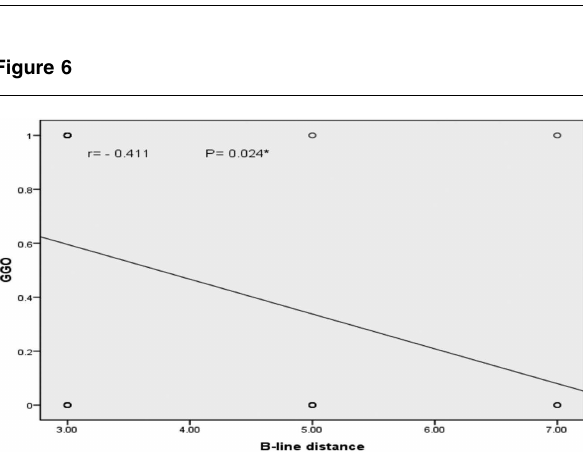
Correlation between ground-glass opacities (GGO) and B-line dis- tance in patients with interstitial lung